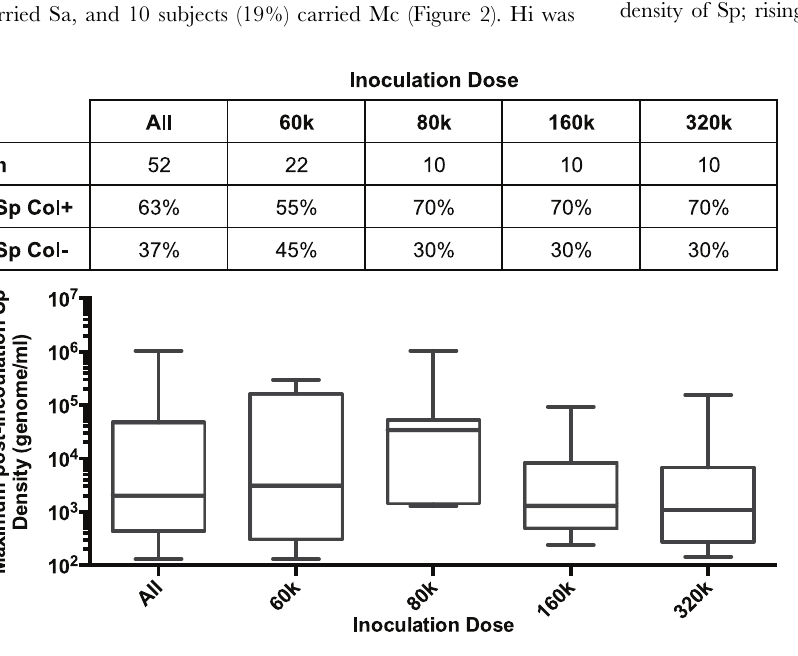
Figure 1. Colonization rates and maximum post-inoculation densities at four inoculation doses. Subjects were administered intra-nasal doses of 60 k, 80 k, 160 k, or 320 k CFU of S. pneumoniae 6B. Comparison of Sp colonization rates and maximum post-inoculation densities rates among subjects in the four dose groups revealed no statistically significant differences. Boxplots indicate median, interquartile range, and range with circles indicating outlier